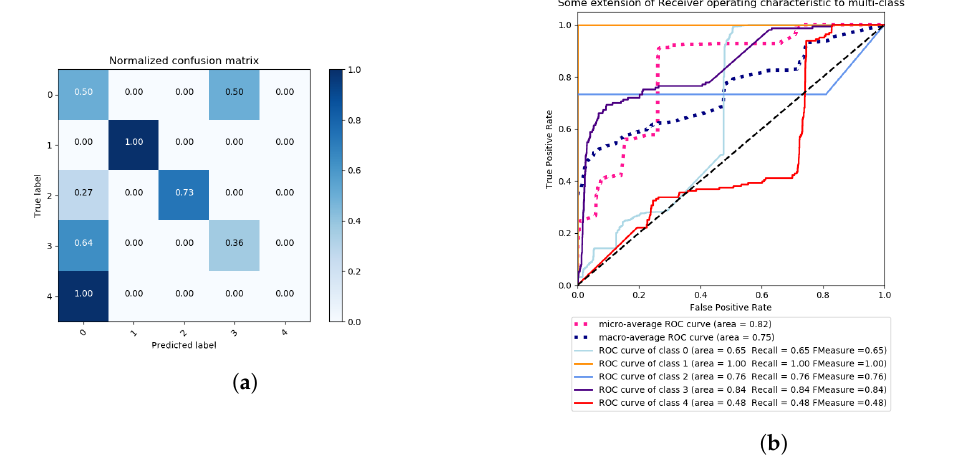
Figure 5. Multi-class problem—Grid Search SVM with: RBF Kernel, One vs. Rest decision function shape, 30 iterations and scoring criterion of accuracy, Confusion Matrix ( a ) and ROC Curves ( b ).